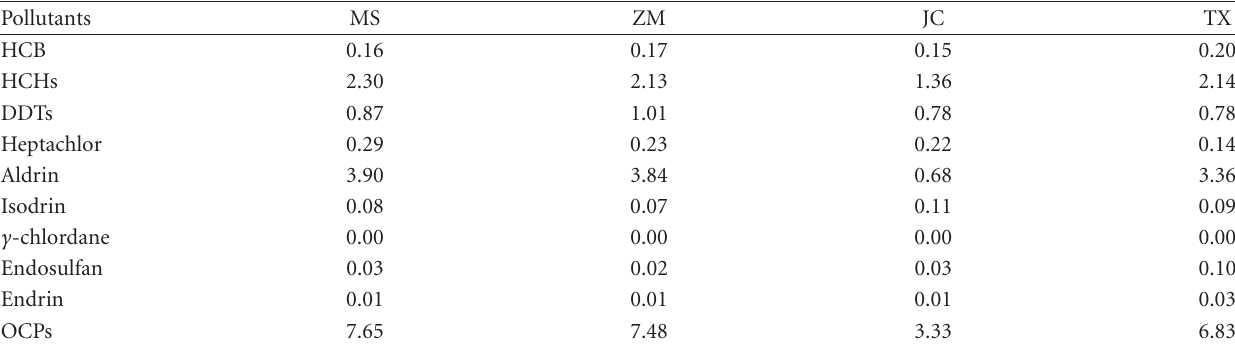
Table 5: The spatial distributions of OCPs in the water from September 2010 to February 2011 (ng/L).